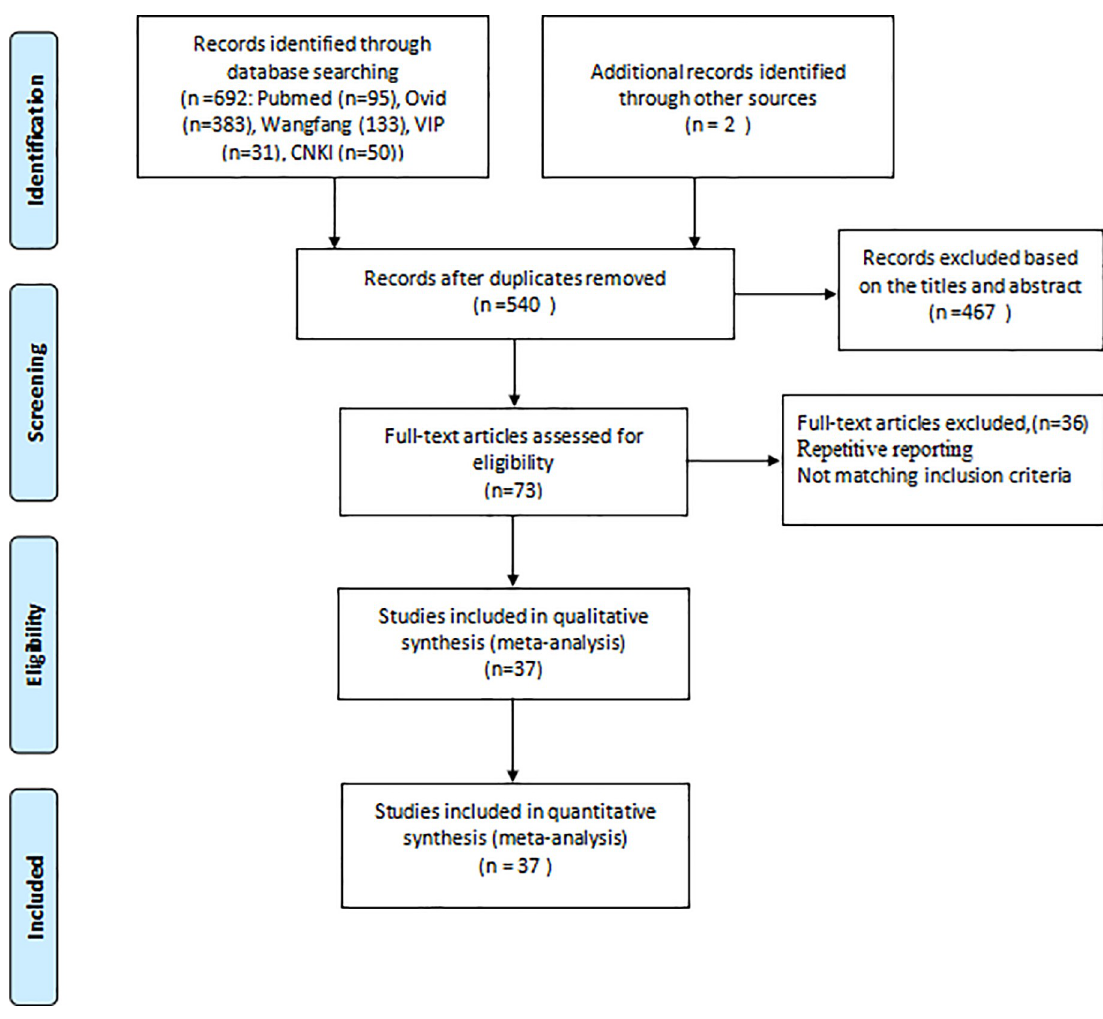
Fig 1. Flow diagram of the selection